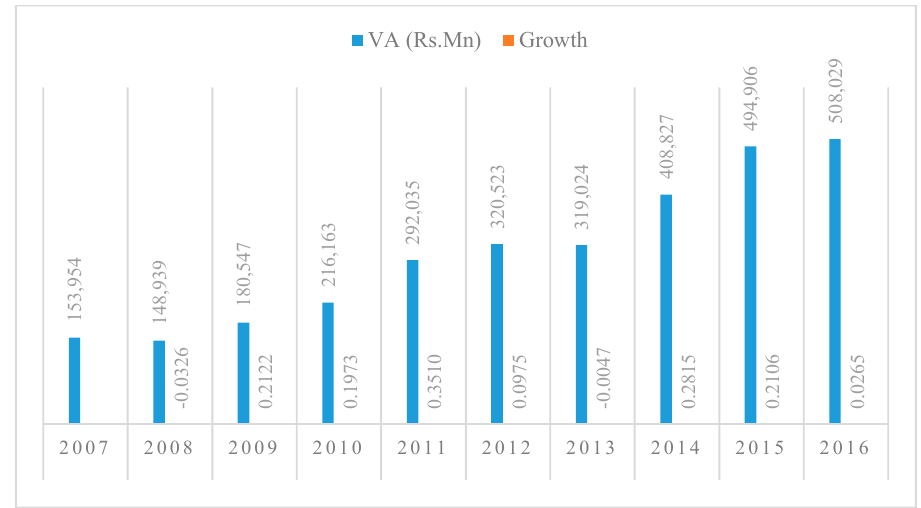
Figure 1. Value-added and value-added growth during the period from 2007 to 2016. Source: compiled by authors.